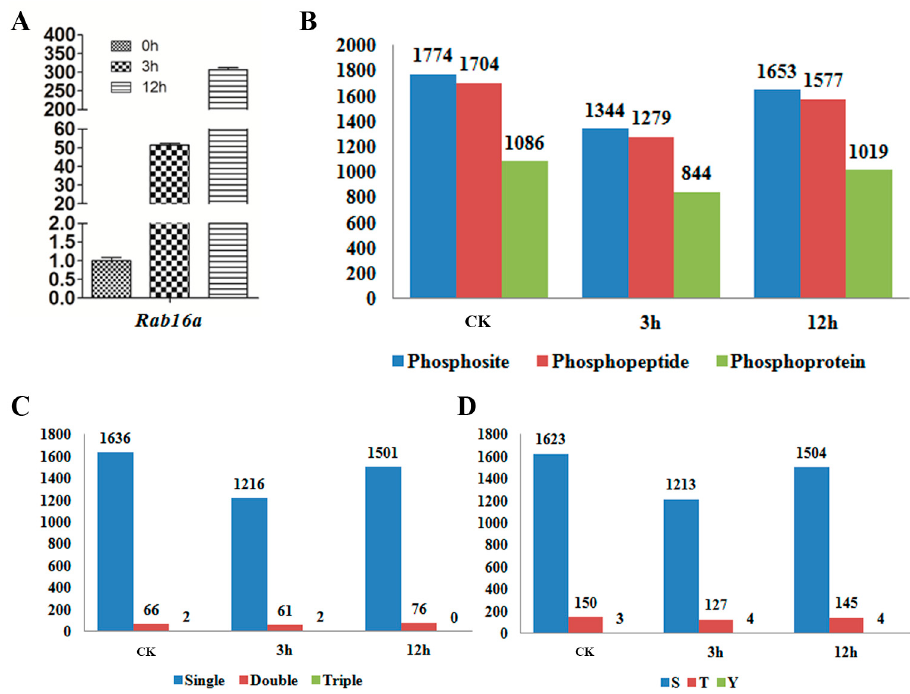
Figure 1. ( A ) qRT-PCR (quantitative Real Time-Polymerase Chain Reaction) analysis of abscisic acid (ABA) responsive gene Rab16a in CK, 3 and 12 h samples; ( B ) The number of identified phosphosites, phosphopeptides and phosphoproteins; ( C ) The counts of phosphopeptides carrying single, double and triple phosphorylation modifications; ( D ) The counts of phosphosites in serine, threonine and tyrosine.